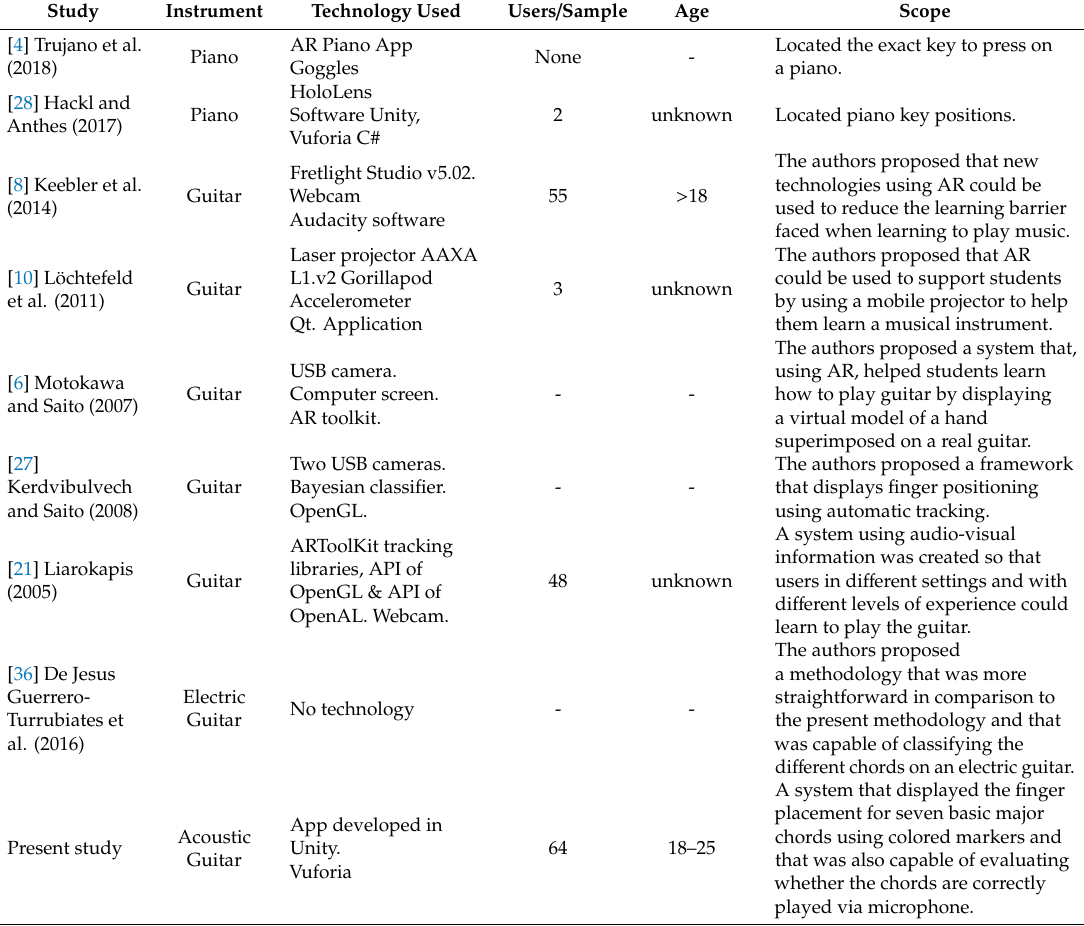
Table 1. Comparison of related existing